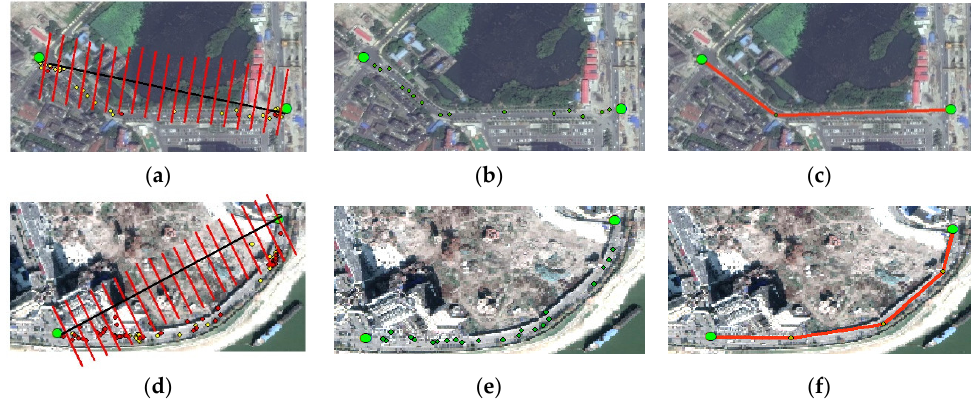
Figure 7. Illustration of different segments fitting. ( a , d ) Space dividing ( b , e ) results extraction based on density sampling ( c , f ) segment creating based on Douglas algorithm.